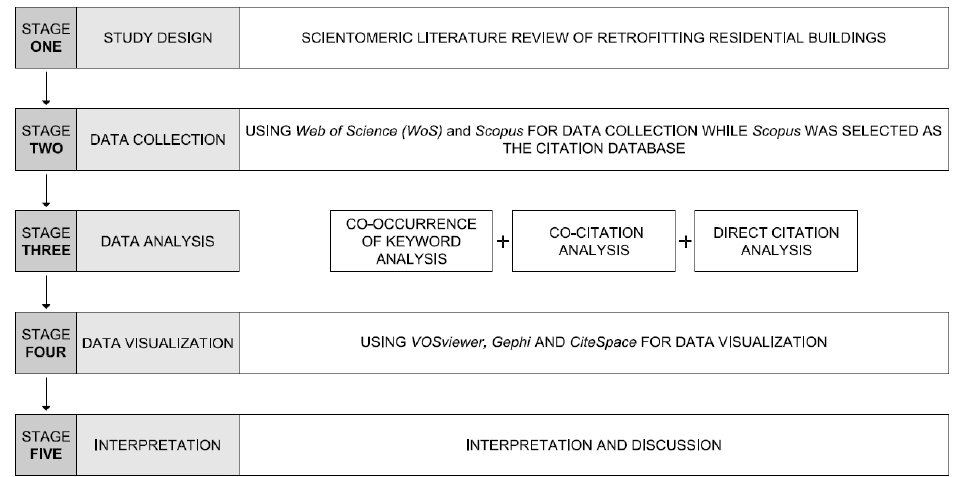
Figure 1. The research flowchart reviewing the literature on the retrofitting of residential buildings.